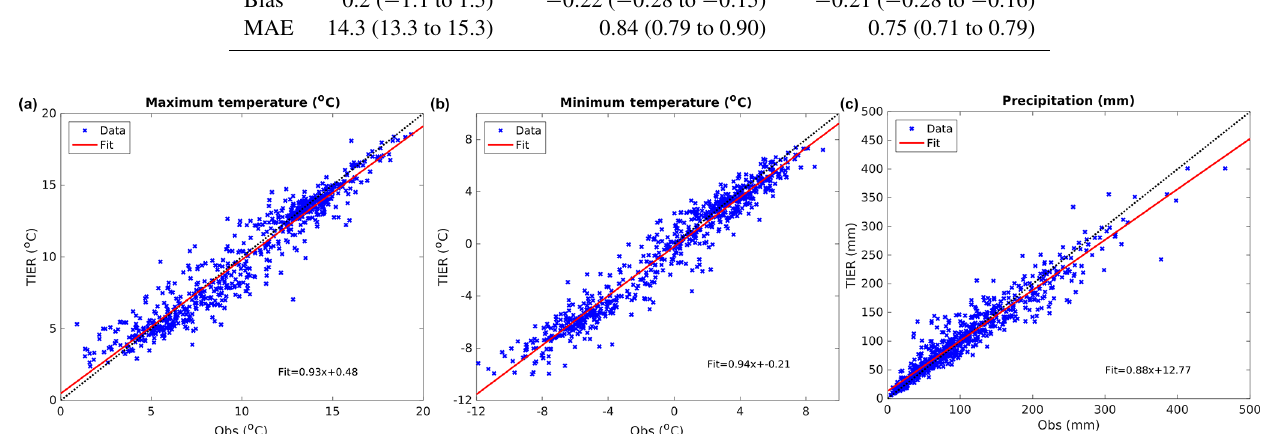
Figure 7. Calibration sample evaluation scatter plots (TIER versus observations) for (a) maximum temperature ( ◦ C), (b) minimum temper- ature ( ◦ C), and (c) precipitation (mm).